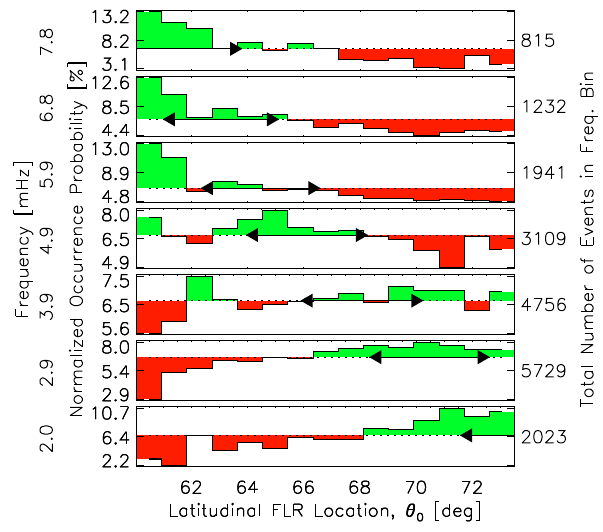
Fig. 13. Distribution of events of different frequency against the latitudinal FLR resonance location ϑ 0 (computed with the FLRD) normalized by the distribution of all events in ϑ 0 . The percentage of occurrence of the events of each frequency bin is depicted as well as the corresponding total number of events to which this percentage is referred (numbers to the right of the figure). Red and green bars show the differences to the mean percentage indicated by the dotted lines. Arrow heads indicate latitudes computed for the correspond- ing frequencies using the relations found by Samson and Rostoker (1972) for the local time sectors 17:30–07:30 (lower latitude end) and 07:30–17:30 (upper latitude